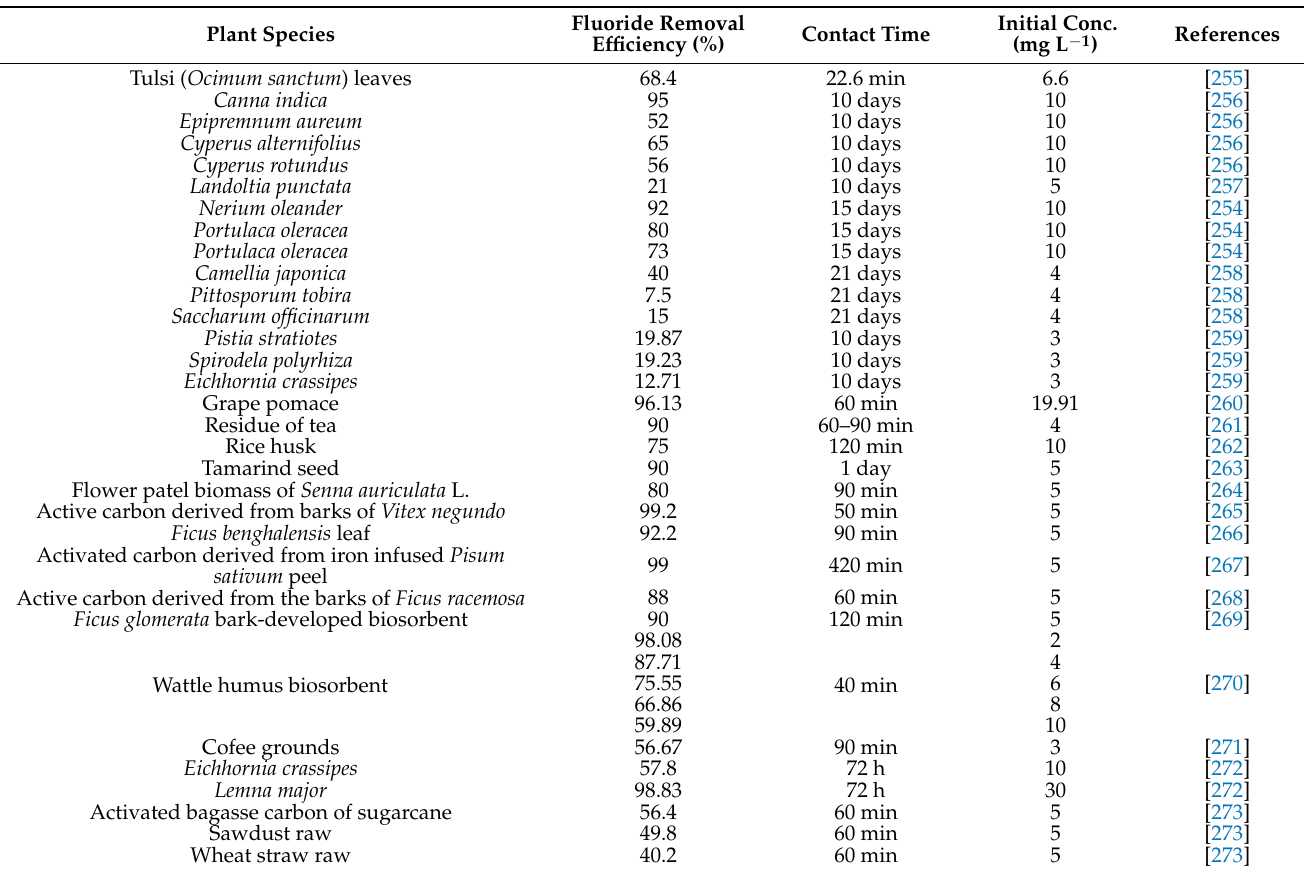
Table 3. Fluoride removal from contaminated water using plant-based systems. Plant